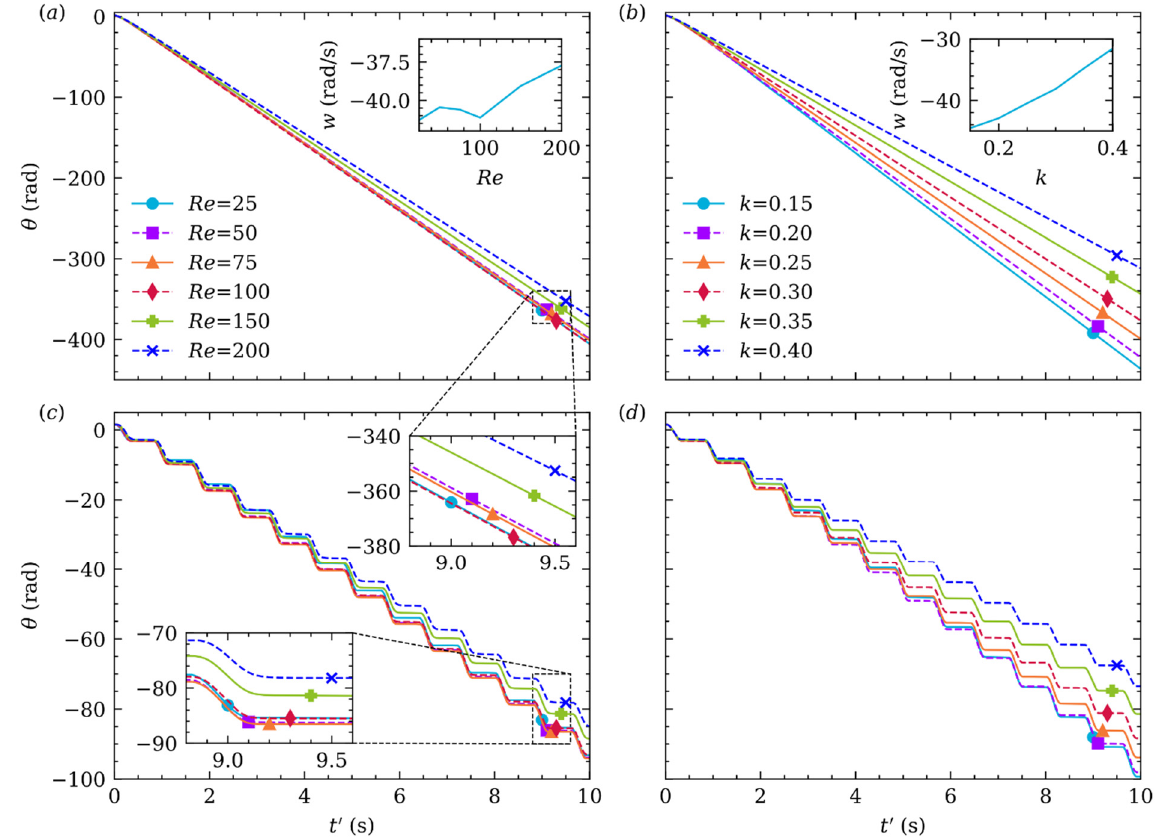
Figure 9. The particle orientation at different Re ( a , c ) and k ( b , d ). Meanwhile, ( a , b ) is in non-pulsatile and ( c , d ) in pulsatile flow.